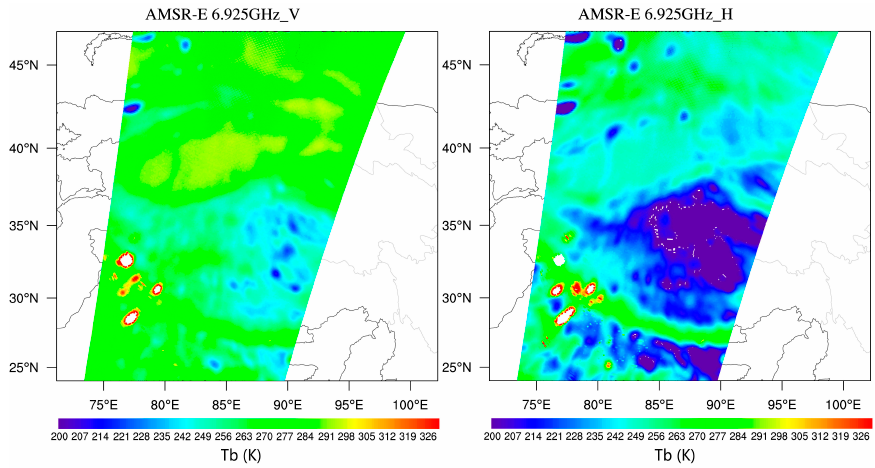
Figure 7. Advanced Microwave Scanning Radiometer-Earth Observing System (AMSR-E) coverages for brightness temperatures ( Tb in K ) at a frequency 6.925 GHz used for simulation and comparison between vertical ( V ) polarization and horizontal ( H ) polarization.